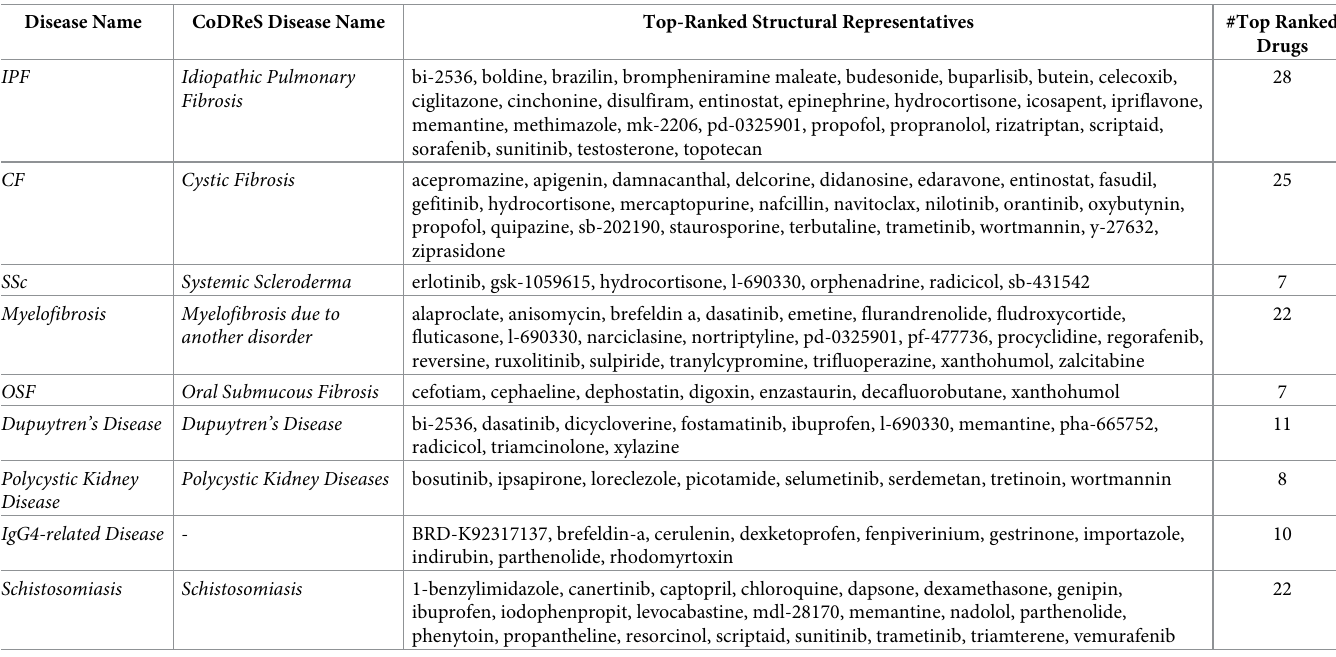
Table 4. The re-ranked repurposed drugs for the respective fibrotic diseases. Disease